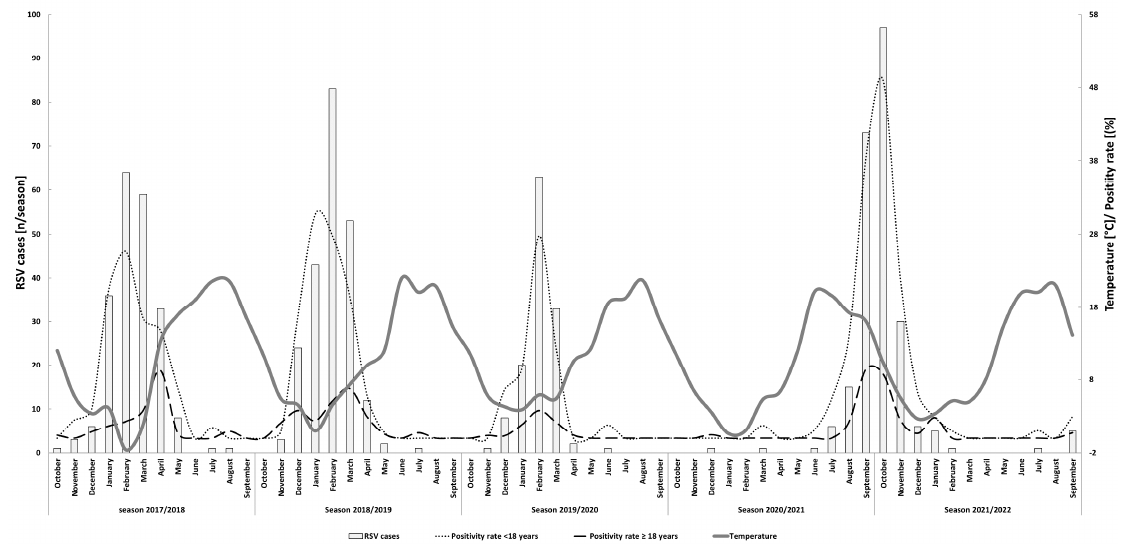
Figure 2. Monthly RSV cases ( n = 803), positivity rates of the RSV assay and mean temperature during the study period. Note the two different y-axes: the left axis refers to the absolute numbers of detected RSV cases (light grey bars) while the right axis refers to the mean temperature of the respective month [°C] (dark grey line), the positivity rate for the pediatric patients under the age of 18 years [%] (black dotted line), and the positivity rates for adult patients [%] (black dashed line). The x-axis is labeled according to the pre-pandemic definition that was used to define the start and end of a respiratory season.